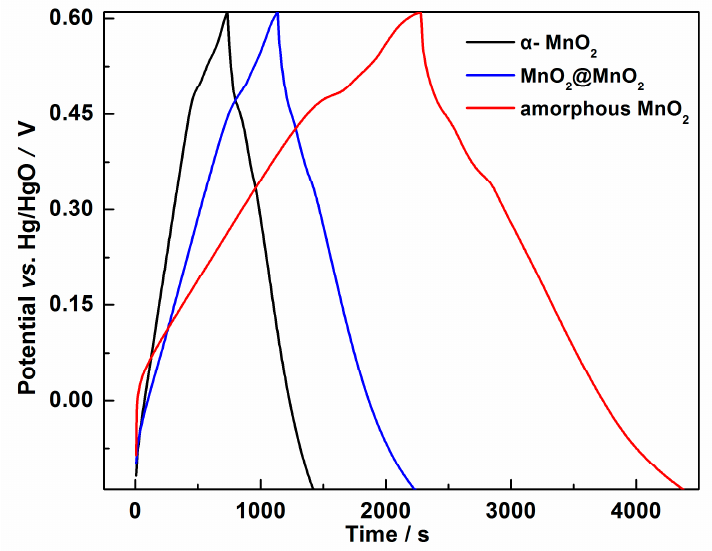
Figure 6. Charge-discharge behavior of the α -MnO 2 , MnO 2 @MnO 2 and amorphous MnO 2 electrodes at current density of 0.1 A·g − 1 .